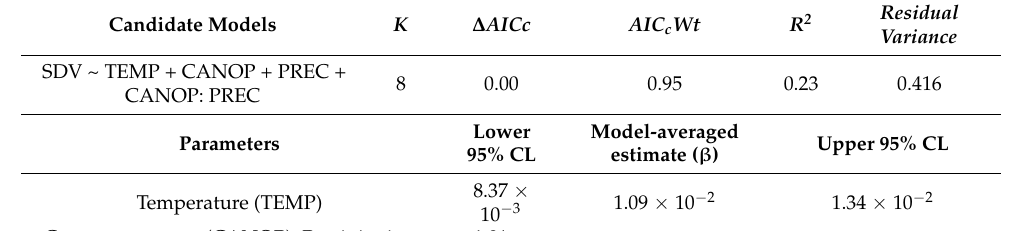
Table 7. Most parsimonious model explaining daily variation of stem diameter ( SDV ) with the number of parameters ( K ), difference in AIC c compared to highest-ranked model ( ∆ AIC c ), AIC c model weight ( AIC c Wt ) and the predictive power (marginal R 2 ). Parameters appearing in the second